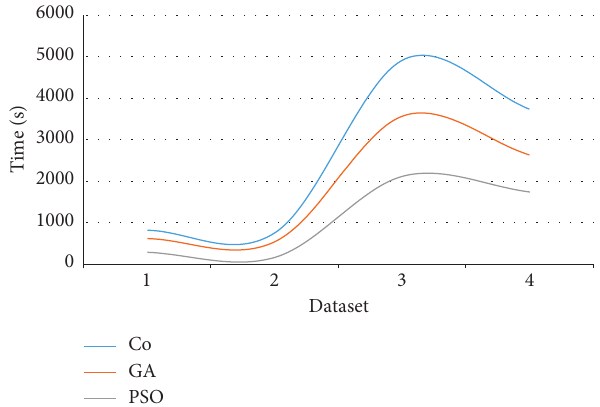
Figure 9: Comparison of Co, GA, and PSO when applied to the Plants